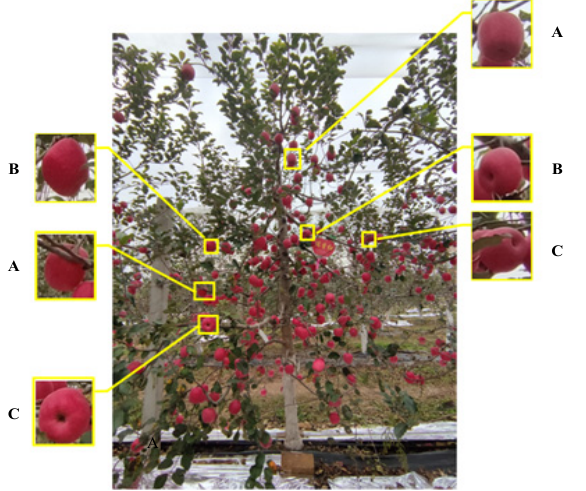
Figure 8. Classification of apple growth posture: A represents calss A; B represents class B; C repre- sents class C.